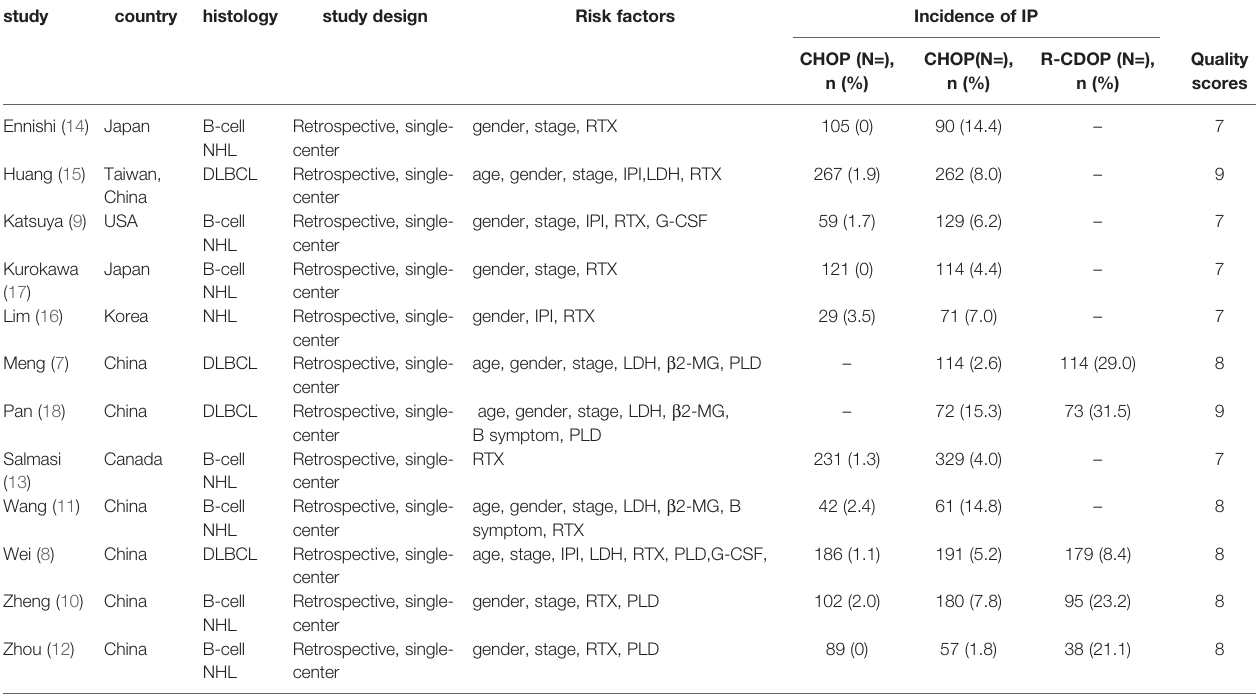
TABLE 1 | The characteristic of included